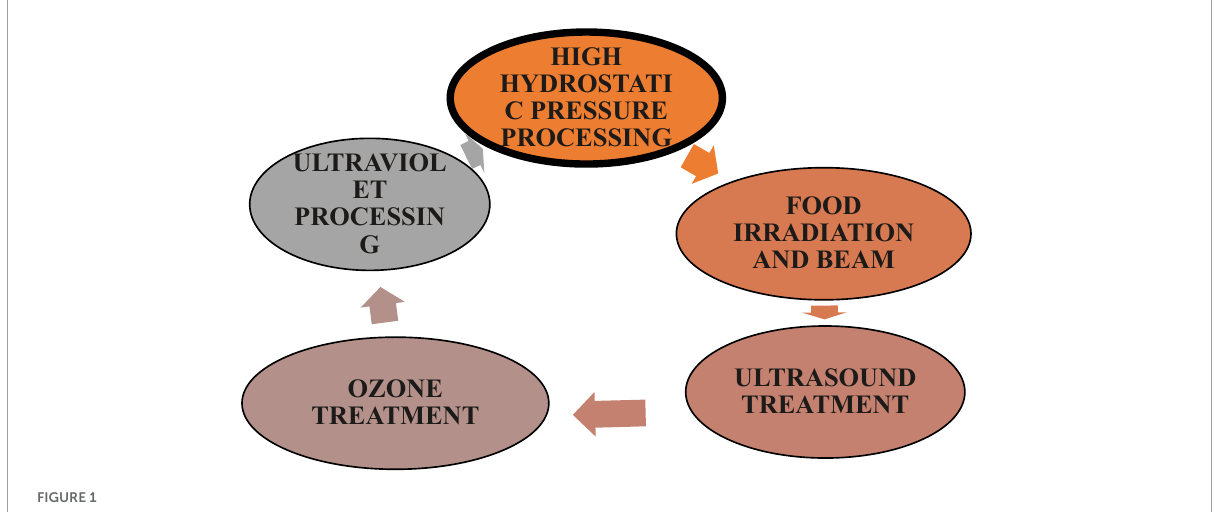
FIGURE1 Different types of novel techniques used in meat